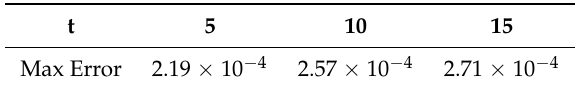
Table 2. The results of solving the partial differential equation (PDE) Equation (24) with the radial basis function-finite difference (RBF-FD) method at t =